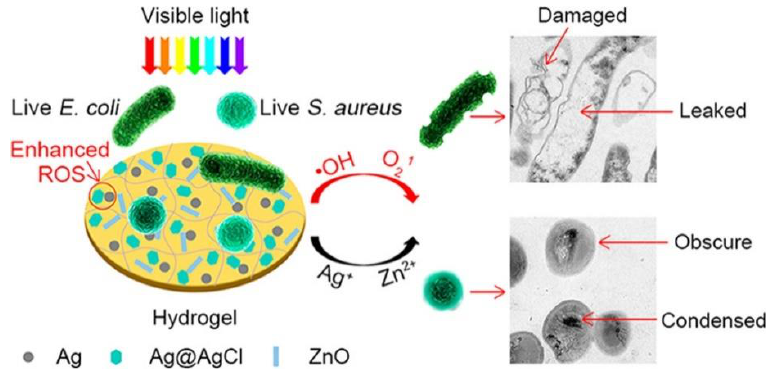
Figure 16. Schematic illustration of the antibacterial action of the Ag/Ag@AgCl/ZnO nanocomposite hydrogel under visible light irradiation on E. coli and S. aureus bacteria strains. Reprinted with permission from ACS Nano 2017, 11, 9, 9010–9021. Copyright 2017, American Chemical Society [88].